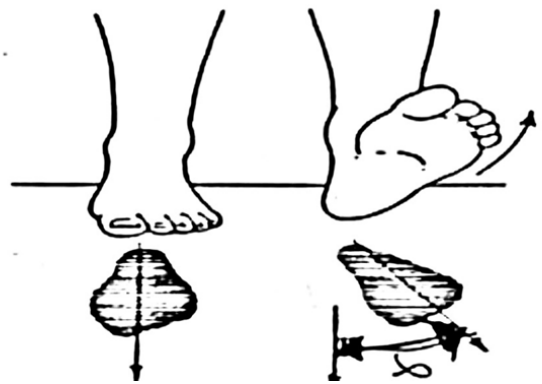
Figure 2. Foot progression representing the rotation of the foot in horizontal plane.